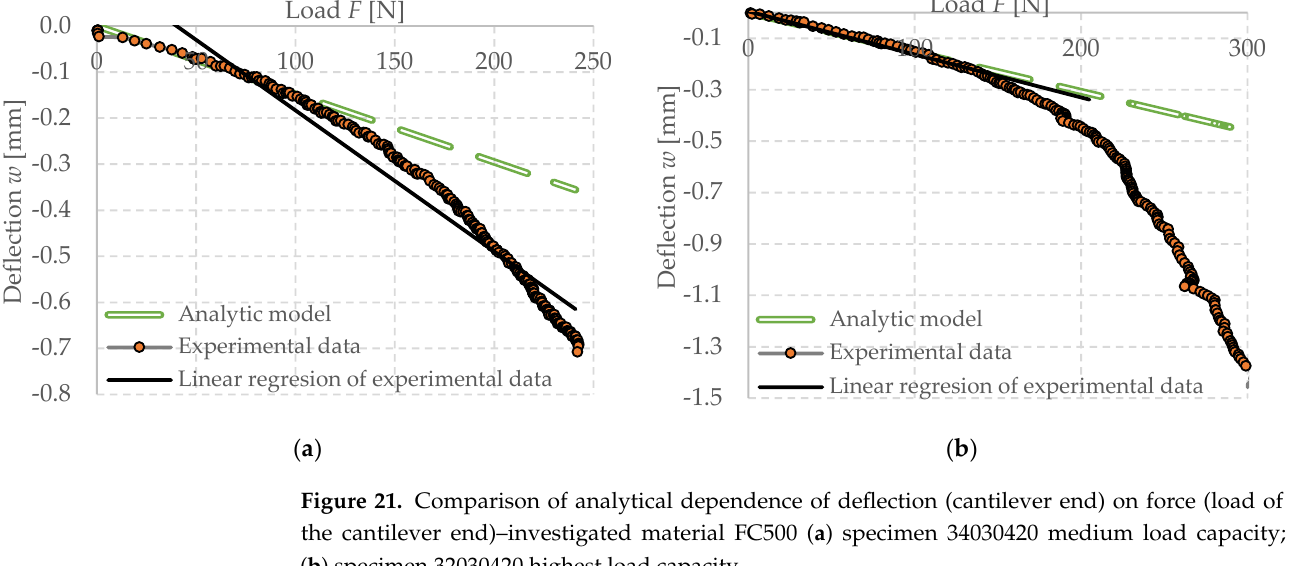
Figure 21. Comparison of analytical dependence of deflection (cantilever end) on force (load of the cantilever end) – investigated material FC500 ( a ) specimen 34030420 medium load capacity; ( b ) specimen 32030420 highest load capacity.